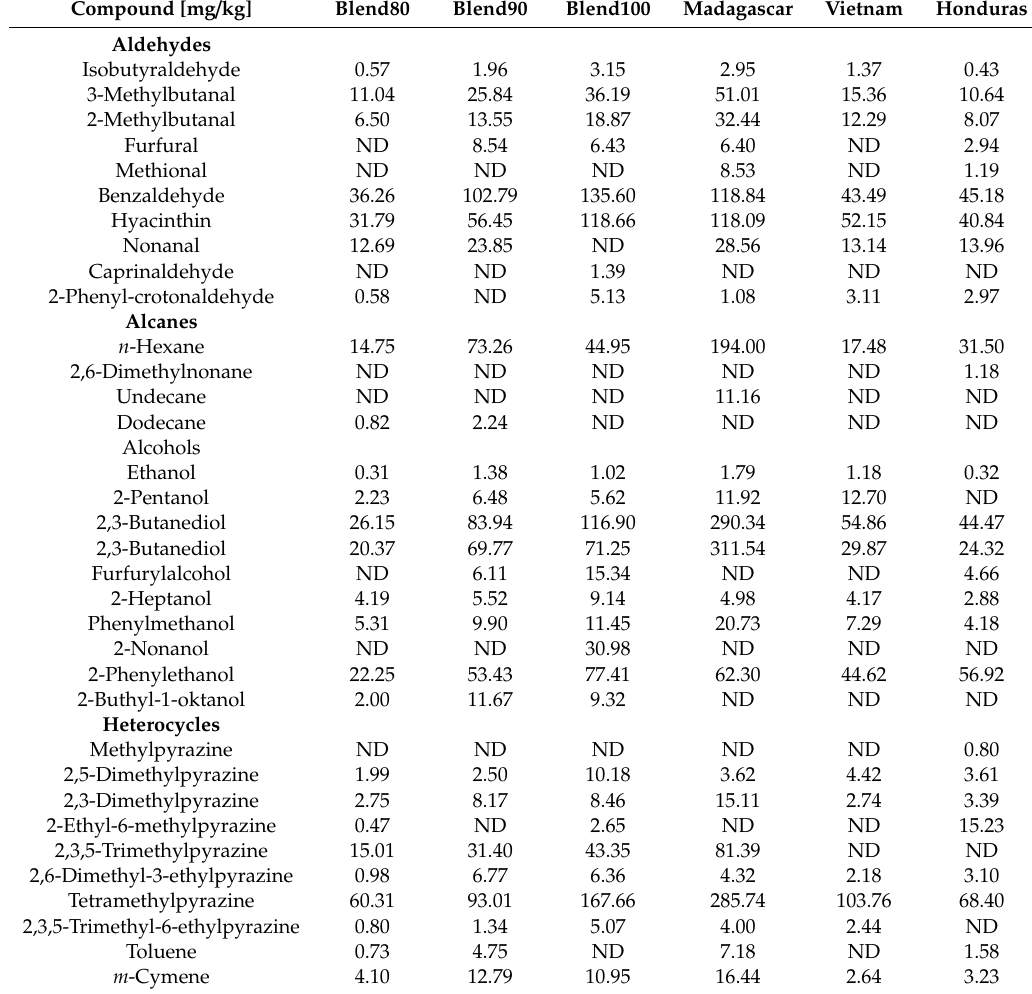
Table 4. The aroma composition of